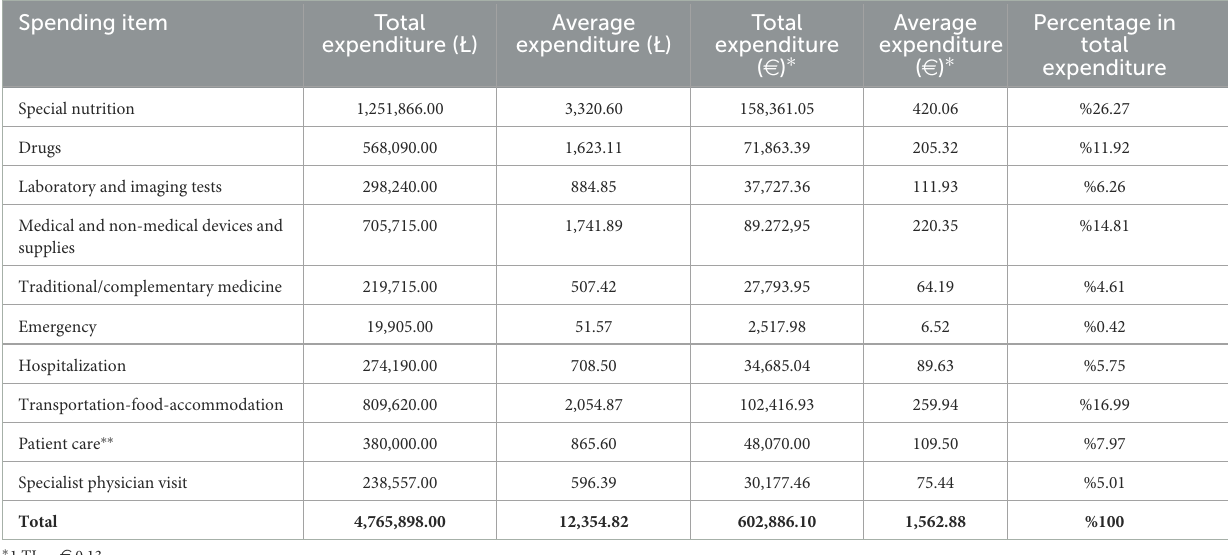
TABLE 3 Out-of-pocket healthcare expenditures over the past year.